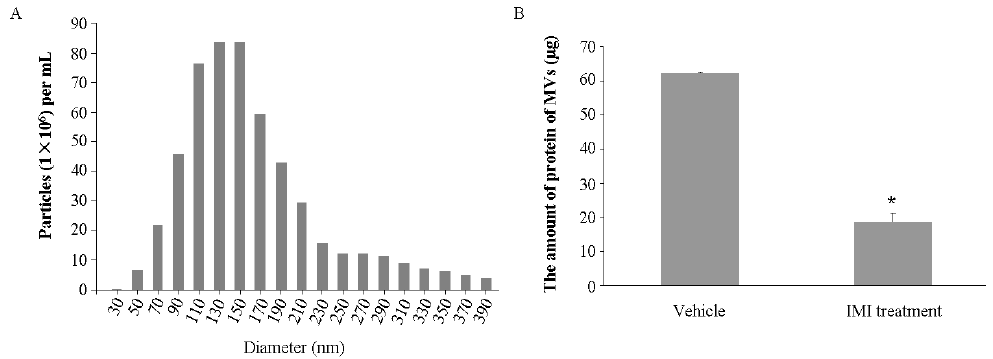
Figure 1. Characterization of osteoblast-derived microvesicles (MVs). ( A ) The size distribution and total number of microvesicles from osteoblast were measured by Nanoparticle Tracking Analysis (NanoSight); ( B ) The total amount of protein of MVs shed from UAMS-32P cells with or without imipramine treatment (obtained from 4 × 10 7 cells). Each bar represents the mean ± standard deviation ( n = 3). * p < 0.05 by Student’s t test. Vehicle: without imipramine treatment; IMI: with imipramine treatment.